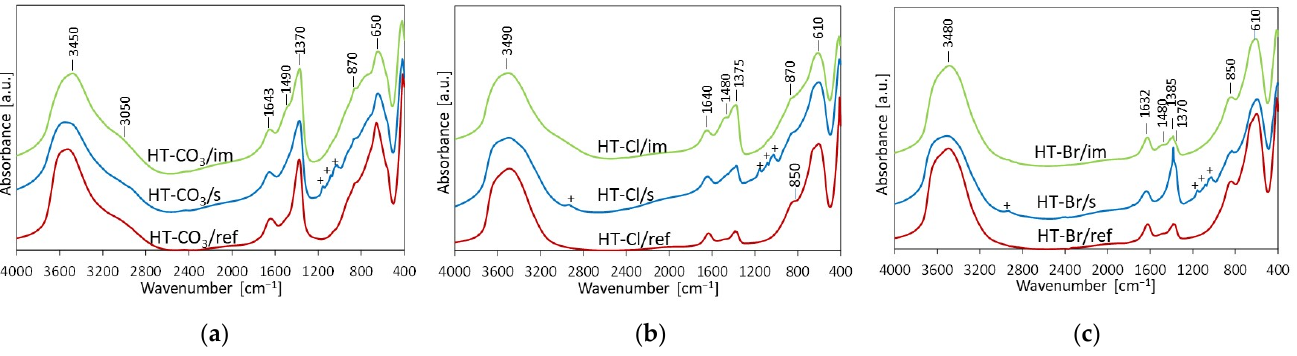
Figure 3. FTIR spectra of the synthesized HT materials: ( a ) carbonate forms; ( b ) chloride forms; ( c ) bromide forms (+ bands originating from the remnants of starch).